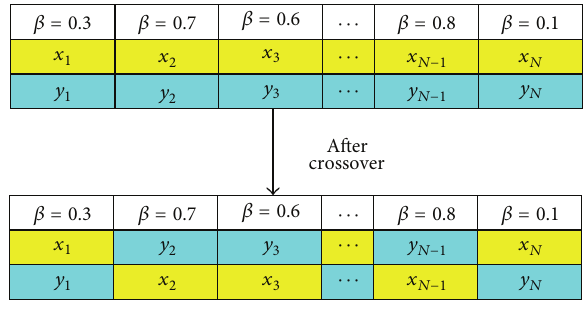
Figure 3: A scheme of random crossover.